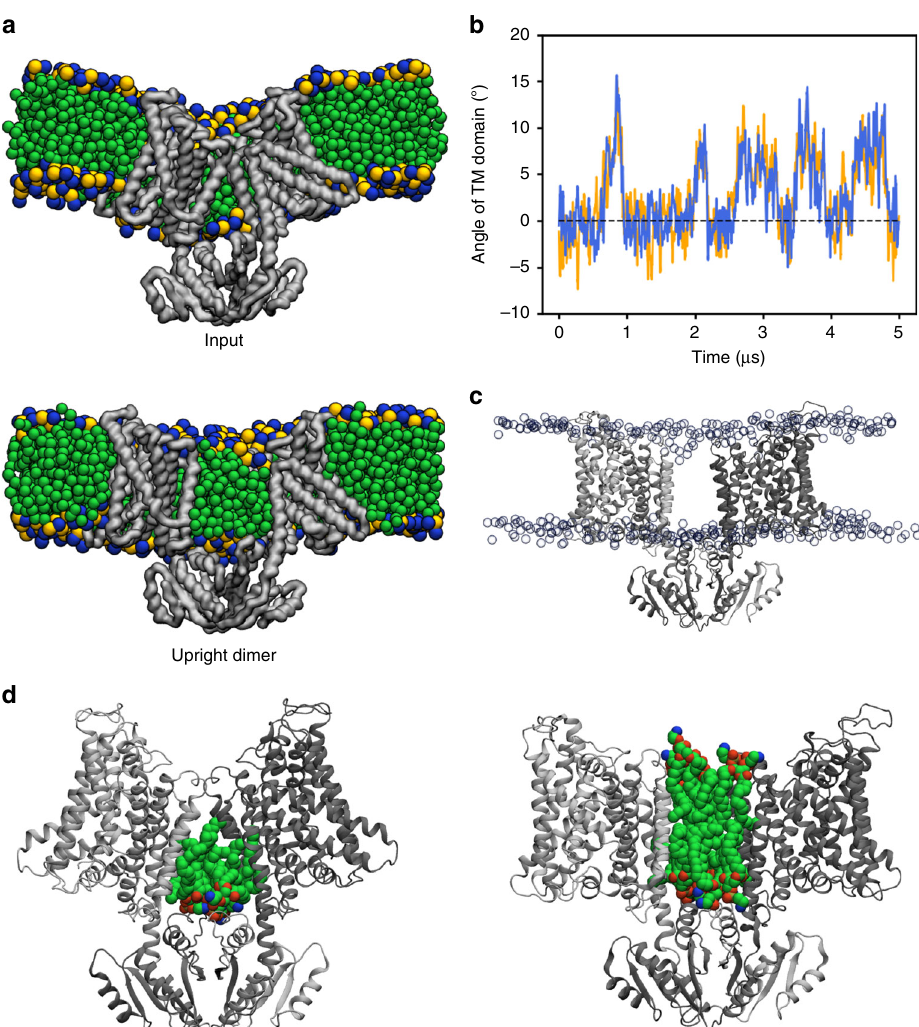
Fig. 3 Molecular dynamics simulations of KimA in a lipid bilayer. a Cut-away views of KimA dimer in a membrane, taken from the CG simulation data. The protein backbone is shown as grey surface and the POPE lipids as green, yellow and blue spheres. b Representative plot of the angle between the TM domains over time for the CG simulations; n = 4 independent simulations (see Supplementary Fig. 5 for full data and a schematic of how the angles were computed). c Upright dimer position as determined using ~2 µ s of fully atomistic simulation. Protein shown as grey cartoon, lipid phosphates as semi- transparent blue circles. n = 3 repeats, with the upright dimer sampled in 2/3. d Views from atomistic simulation showing the lipid molecules (as coloured spheres) present between the KimA